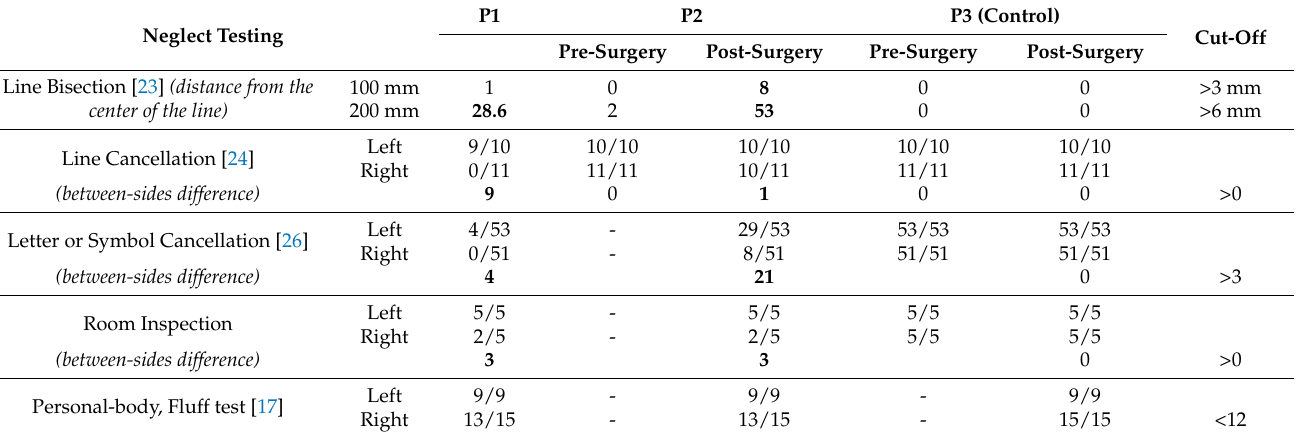
Table 1. The clinical testing of P1 and P2 (post-surgery) revealed clear signs of right visuo-spatial neglect that was present in both the peripersonal and extrapersonal right half of space, but there were no signs of neglect in personal-body space. P3 performed correctly on all the neglect tests. Scores in bold indicate impaired performance. The sign “-” indicates a test that was not